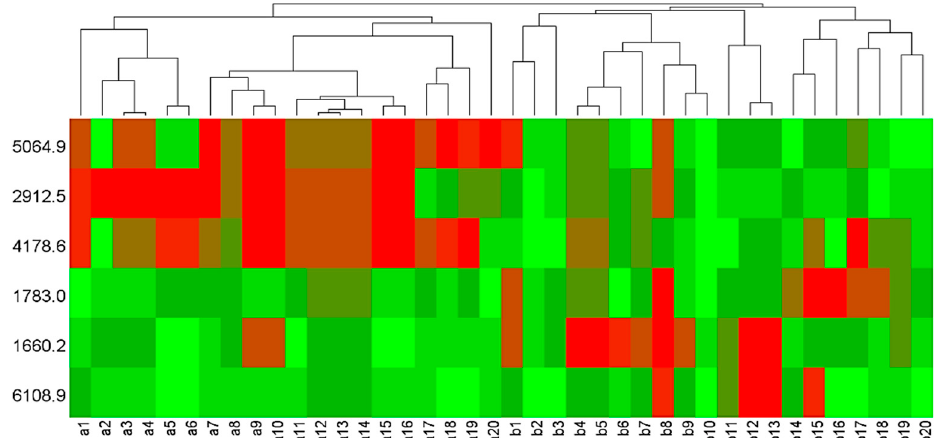
Figure 4. Heat map clustering analysis of six significant mass peaks showed a well-distinguished distribution. (a1–a20 represent post-pubertal group, and b1–b20 represent pubertal group).